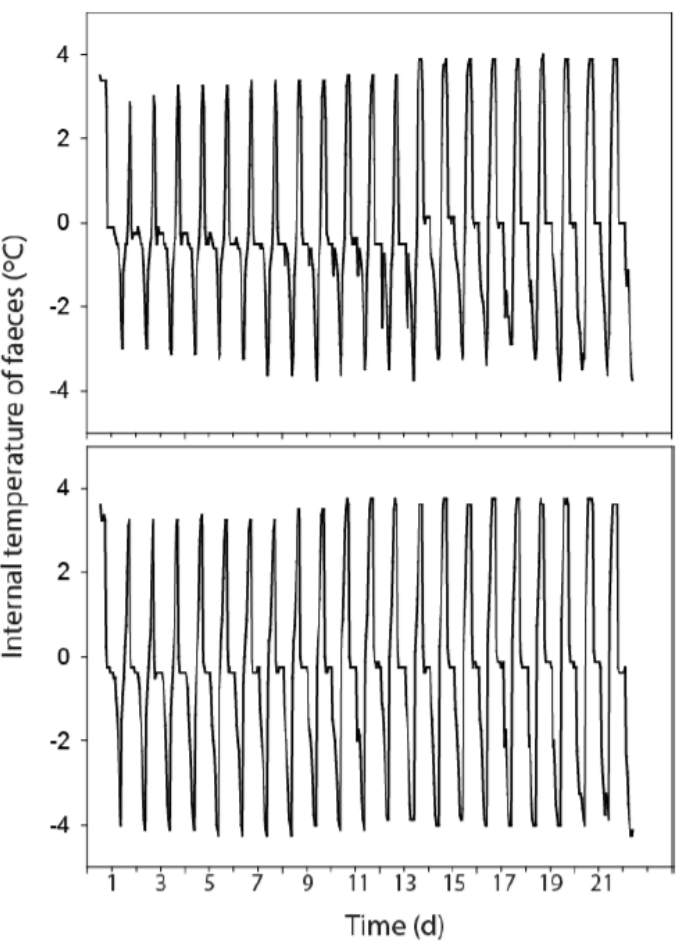
Figure 4. Diurnal patterns of internal temperature of the dairy ( top ) and deer ( bottom ) faecal matrix exposed to the −4 °C freeze–thaw cycle.